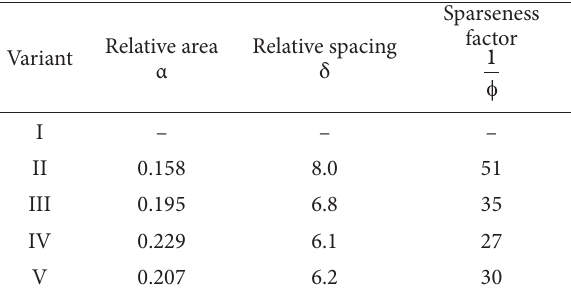
table 3. Volumes (m 3 ) of piles and rafts Volume of Variant